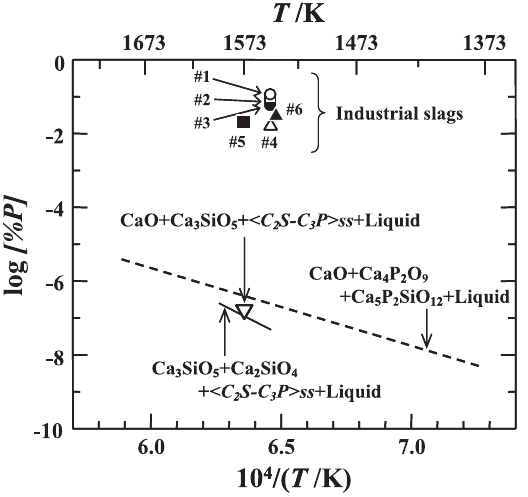
Fig. 5: Schematic illustration of the iso-thermal tetrahedron showing the phase relations in the pseudo-quaternary system CaO-Ca Ca P O -FeO coexisitng with metallic iron at 1573 K. 3 2 9